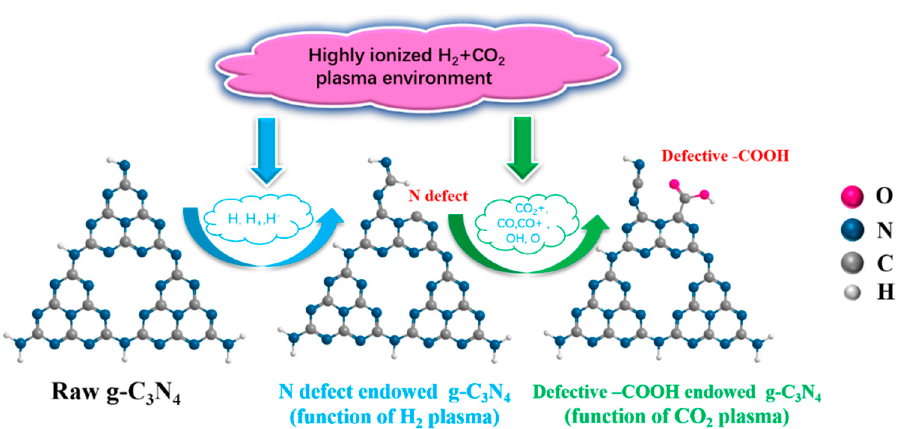
Figure 2. The proposed schematic diagram of preparing carboxyl-defective g-C 3 N 4 by introducing prepositioned point defects through joint H 2 +CO 2 plasma.